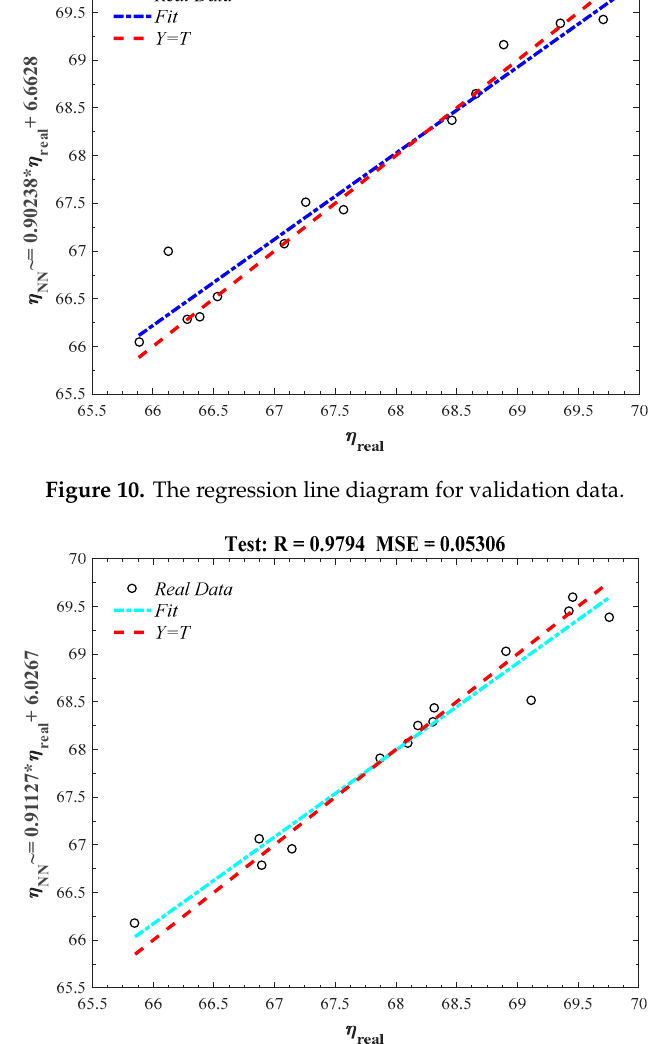
Figure 11. The regression line diagram for test data.